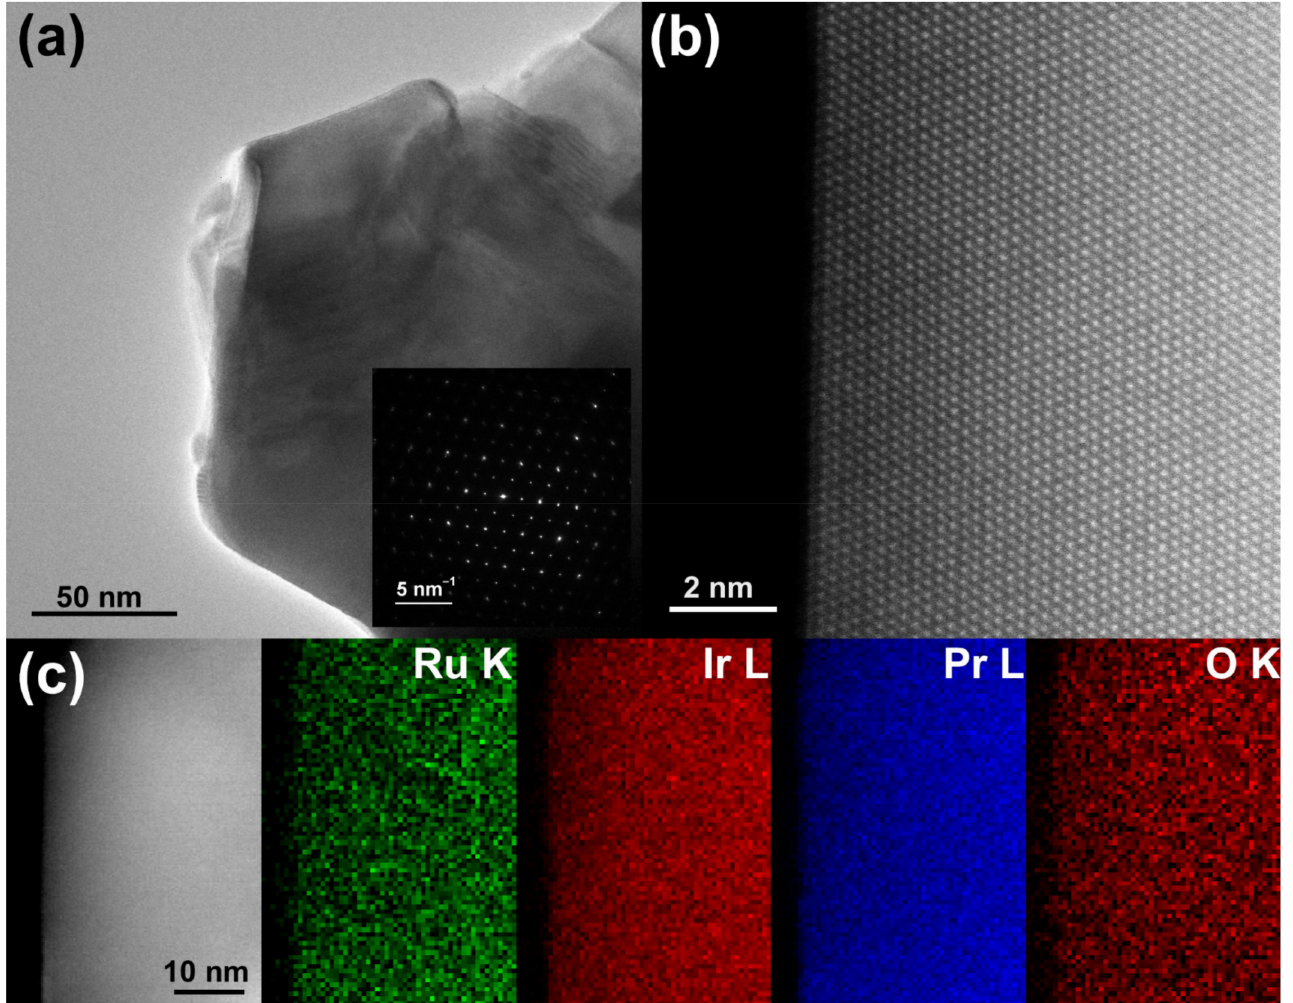
Figure 4. A TEM characterization of as-synthesized Pr 2 (Ru 0.5 Ir 0.5 ) 2 O 7 . ( a ) Low-magnification TEM micrograph with the corresponding selected area electron diffraction (SAED) pattern along the [011] direction (inset). ( b ) HAADF-STEM image with uniform atom distribution. ( c ) EDS mappings of the Ru-K, Ir-L, Pr-L, and O-K